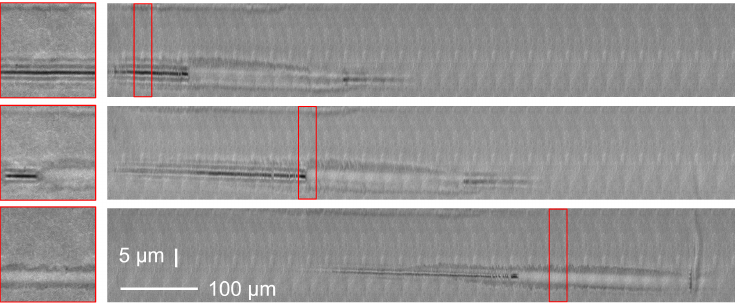
Figure 4. Brightfield microscopy images of damages produced in Gorilla glass with 3 ps pulse duration at a constant energy of 52 µ J as in Figure 4. Position of beam in sample was varied from top to bottom. Please note image aspect ratios (left insets show 1:1 zooms of panels to their